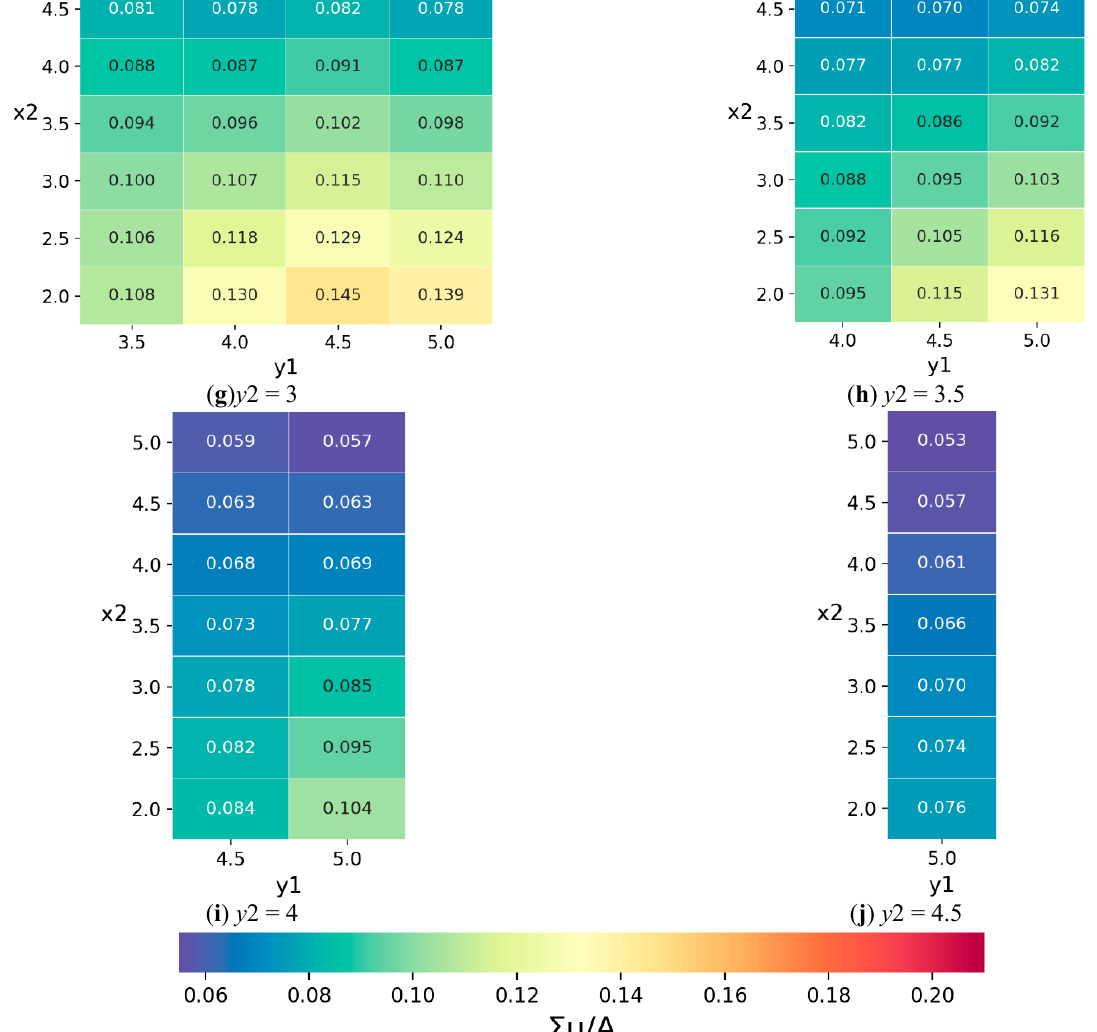
Figure 12. The heat maps of array power density. Each map corresponds to a fixed y 2. The color and the number inside represent the value of the array power density.